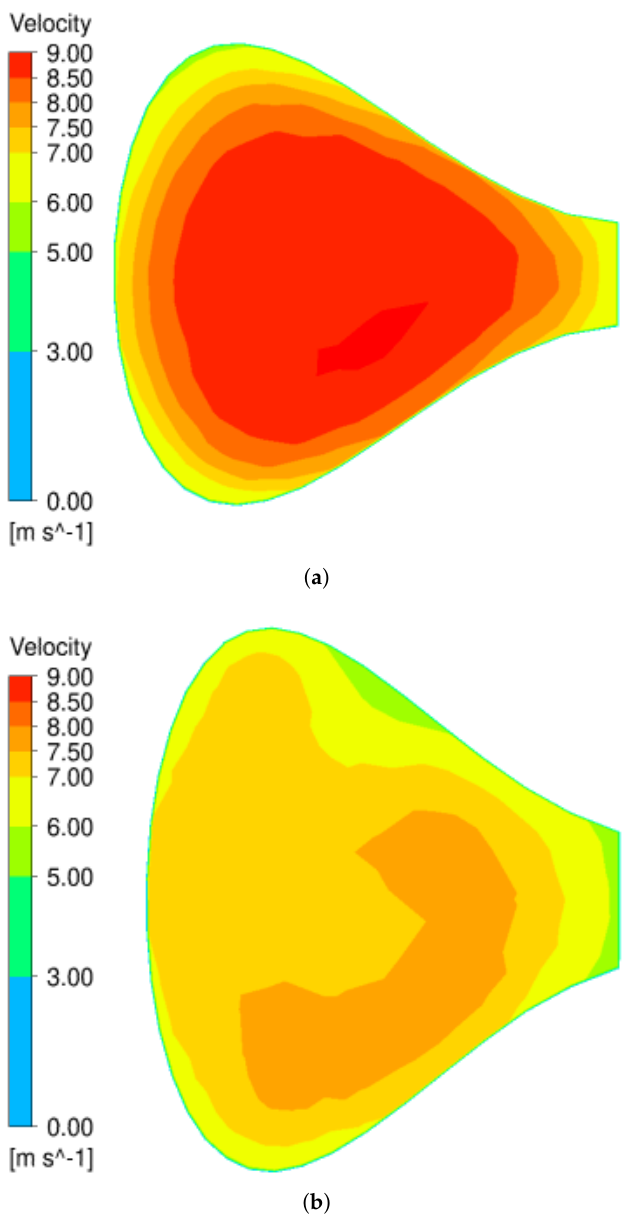
Figure 22. Velocity field at the volute outlet for the baseline ( a ) and the optimized ( b ) geometries. The distribution of the velocity vectors for the baseline and optimized geometry is displayed in Figure 23 for a plane at z = 5 mm. A small recirculation zone is evident near the leading edge of the baseline geometry, while the optimized geometry is characterized by a smooth distribution of the